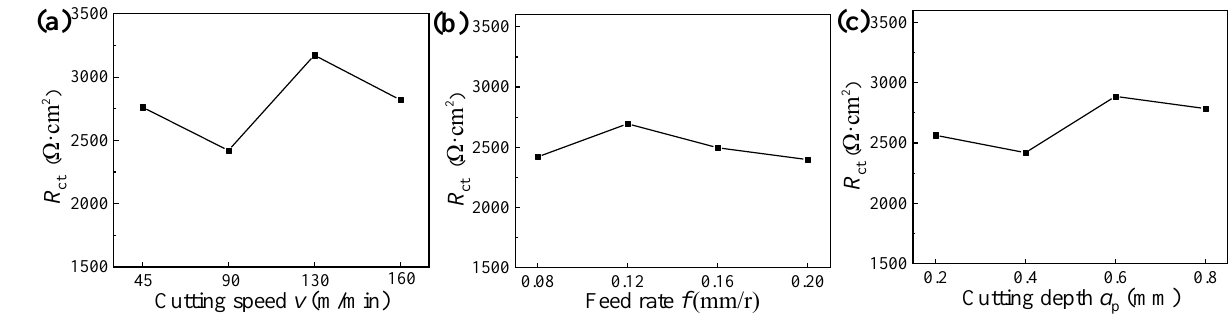
Figure 13. Charge transfer resistances of machined surfaces for samples machined under different cutting parameters: ( a ) cutting speed, ( b ) feed rate, and ( c ) cutting depth.